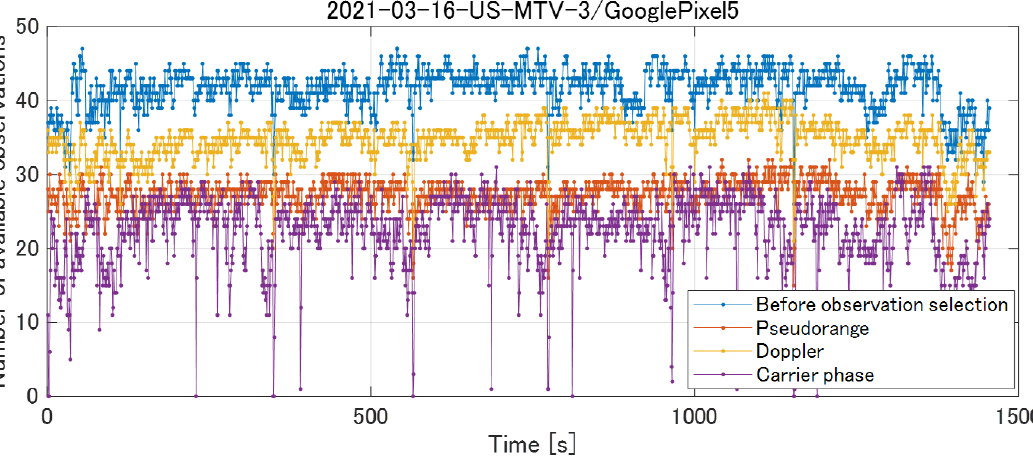
Figure 5. Selection of GNSS observations by preprocessing. Compared to the carrier phase, Doppler is highly available.